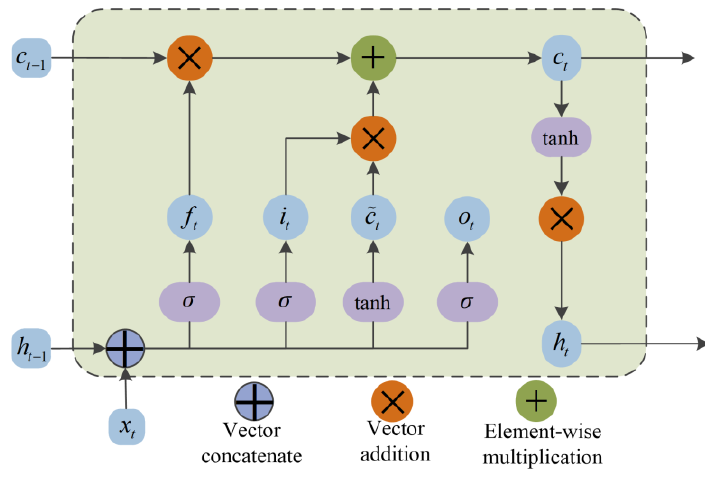
Figure 5. LSTM network structure diagram.